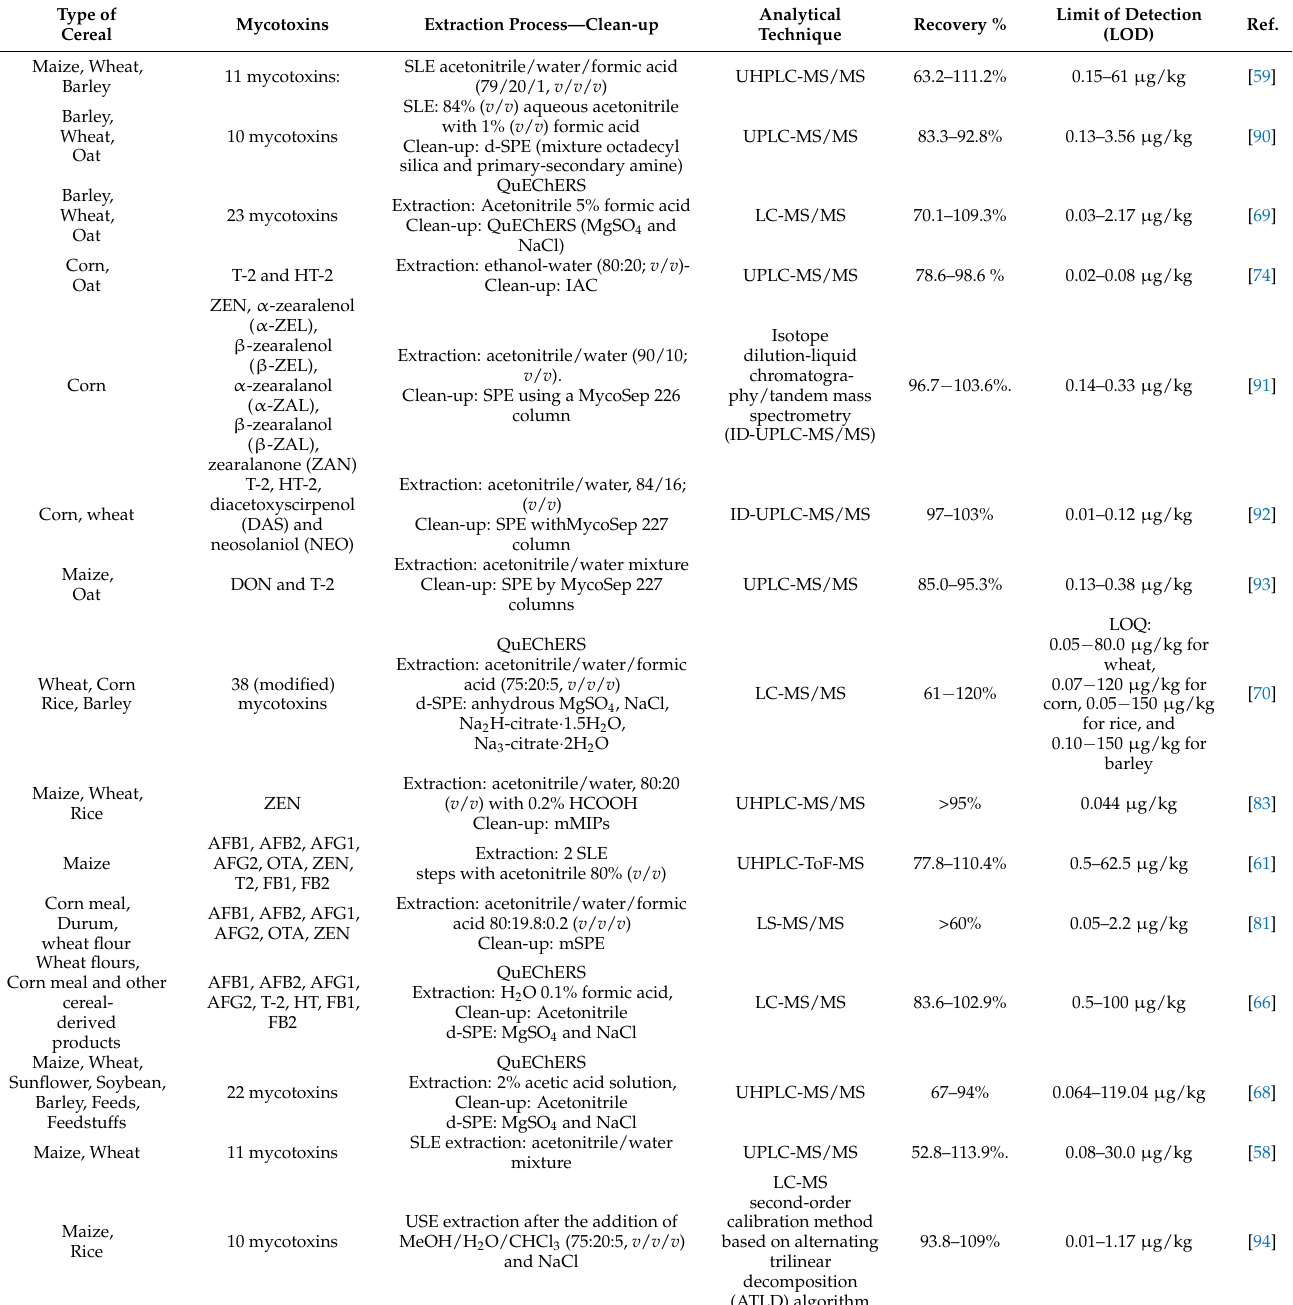
Table 1. HPLC methods used in the analysis of